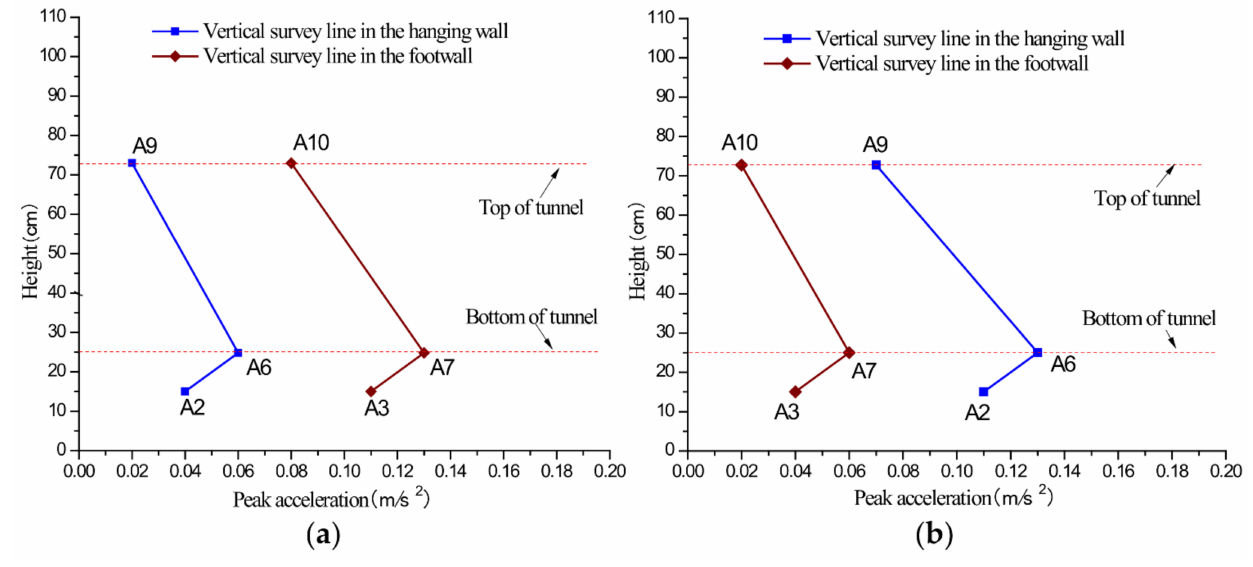
Figure 9. Peak acceleration curves under the scenario of inactive ground fissure: ( a ) vibration exciter at 60 cm; ( b ) vibration exciter at 100